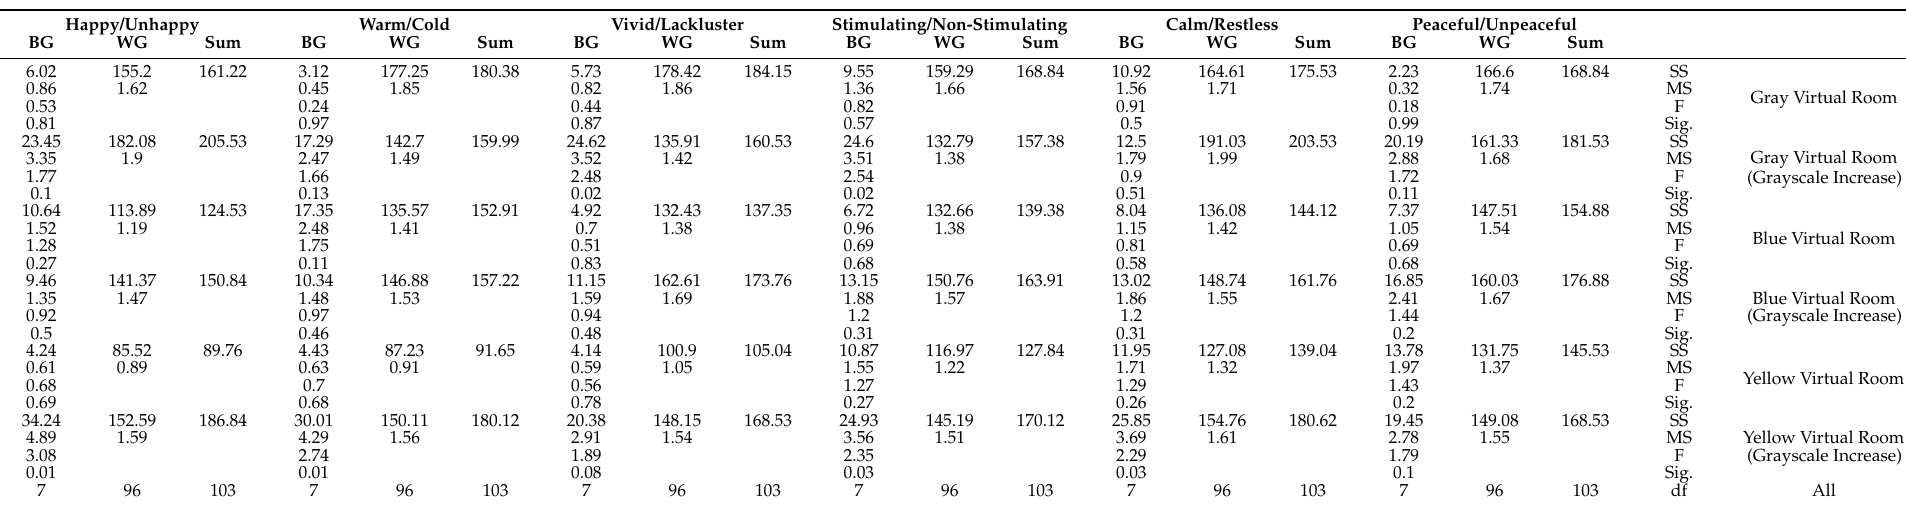
Table 8. Perception of different educational groups of the color of hotel internal